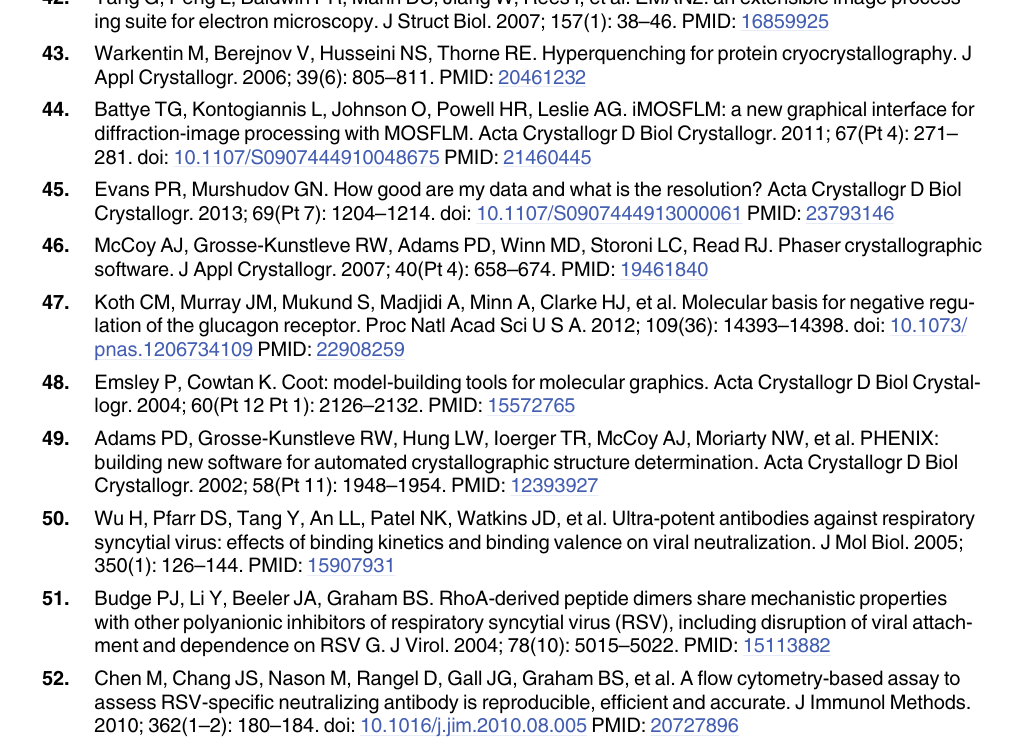
PLOS Pathogens | DOI:10.1371/journal.ppat.1005035 July 10,